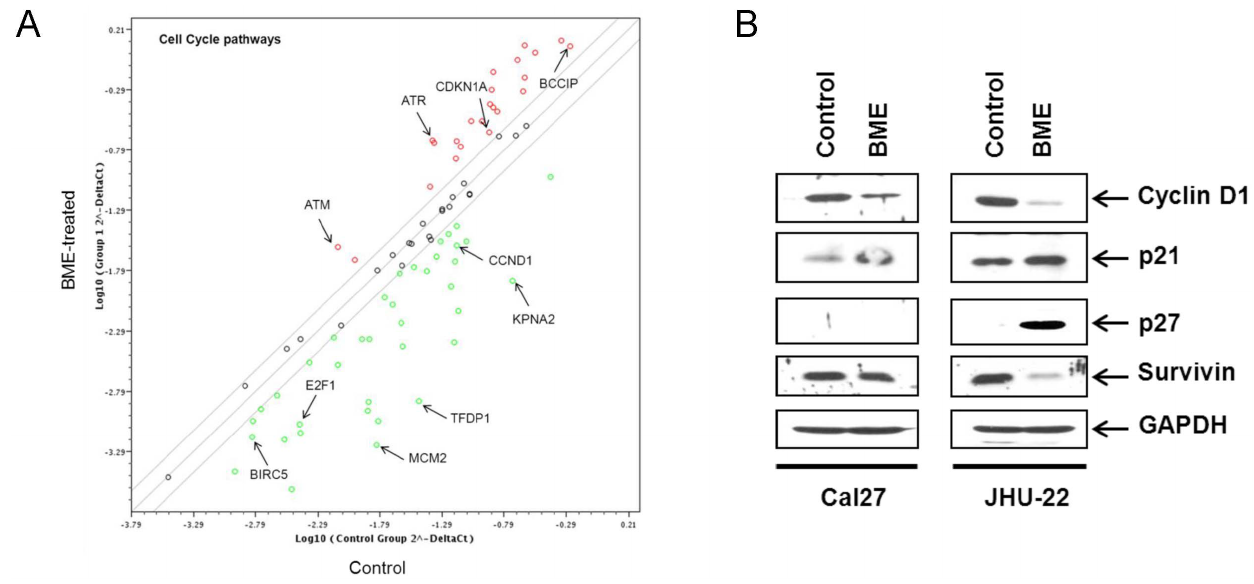
Figure 4. Modulation of cell cycle regulatory molecules following BME treatment in HNSCC cells. (A). Gene expression profiling from RNA of mock or BME treated Cal27 cells was performed using SABiosciences cell cycle pathway qRT-PCR arrays. BME treated cells display a pattern of modulated cell proliferation markers (e.g., ATM, CCND1, MCM2 and BIRC5). (B). Cal27 and JHU-22 cells were treated with BME and cell lysates were analyzed for certain cell cycle molecules for verification. The expression of CyclinD1, p21, p27 and survivin was examined by Western blot using specific antibodies. The blots were reprobed with an antibody to GAPDH for comparison of protein load.